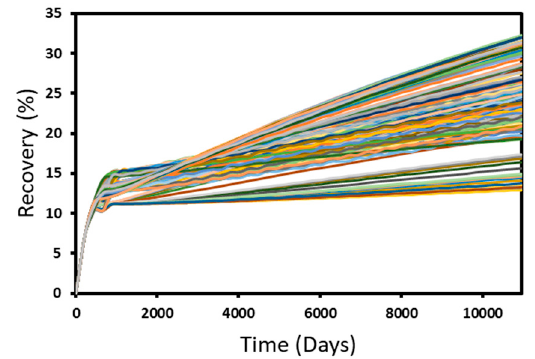
Figure 7. Recovery percentage over time for all